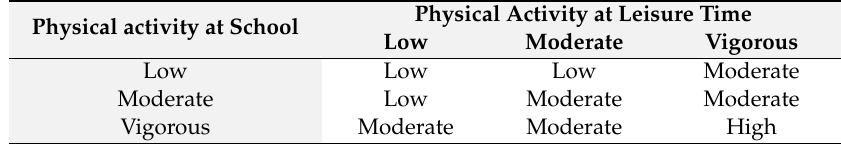
Table 2. Categorizing total physical activity based on data regarding physical activity at school and leisure